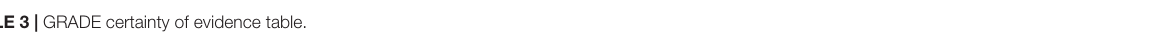
Certainty assessment